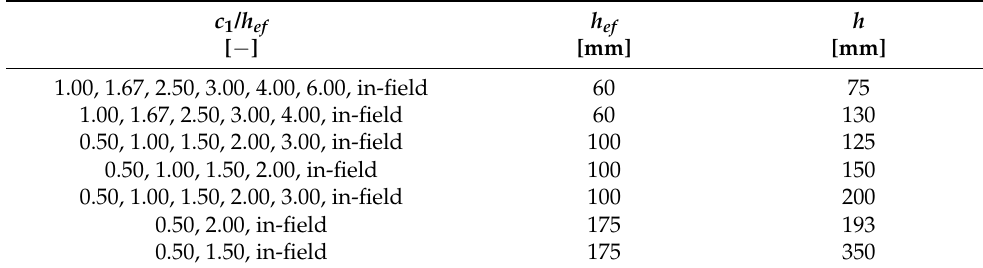
Table 6. Simulation program—influence of edge